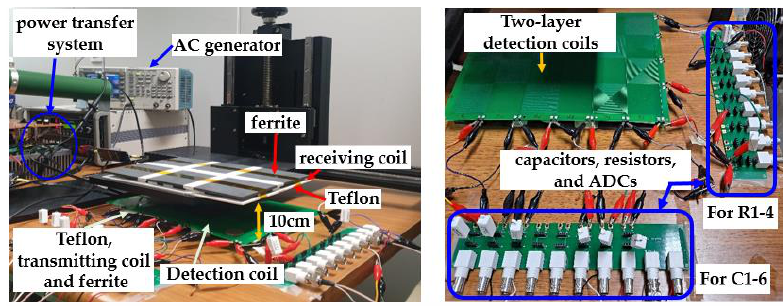
Figure 7. The wireless power transfer system and the proposed MOD system.